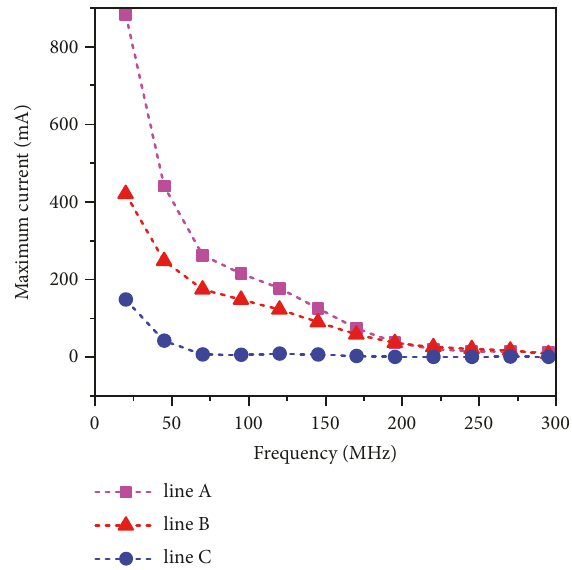
Figure 15: The maximum currents at different frequencies. The conductors are 20 m in length and 0.007 m in radius. The radiation source heights are 1 km.